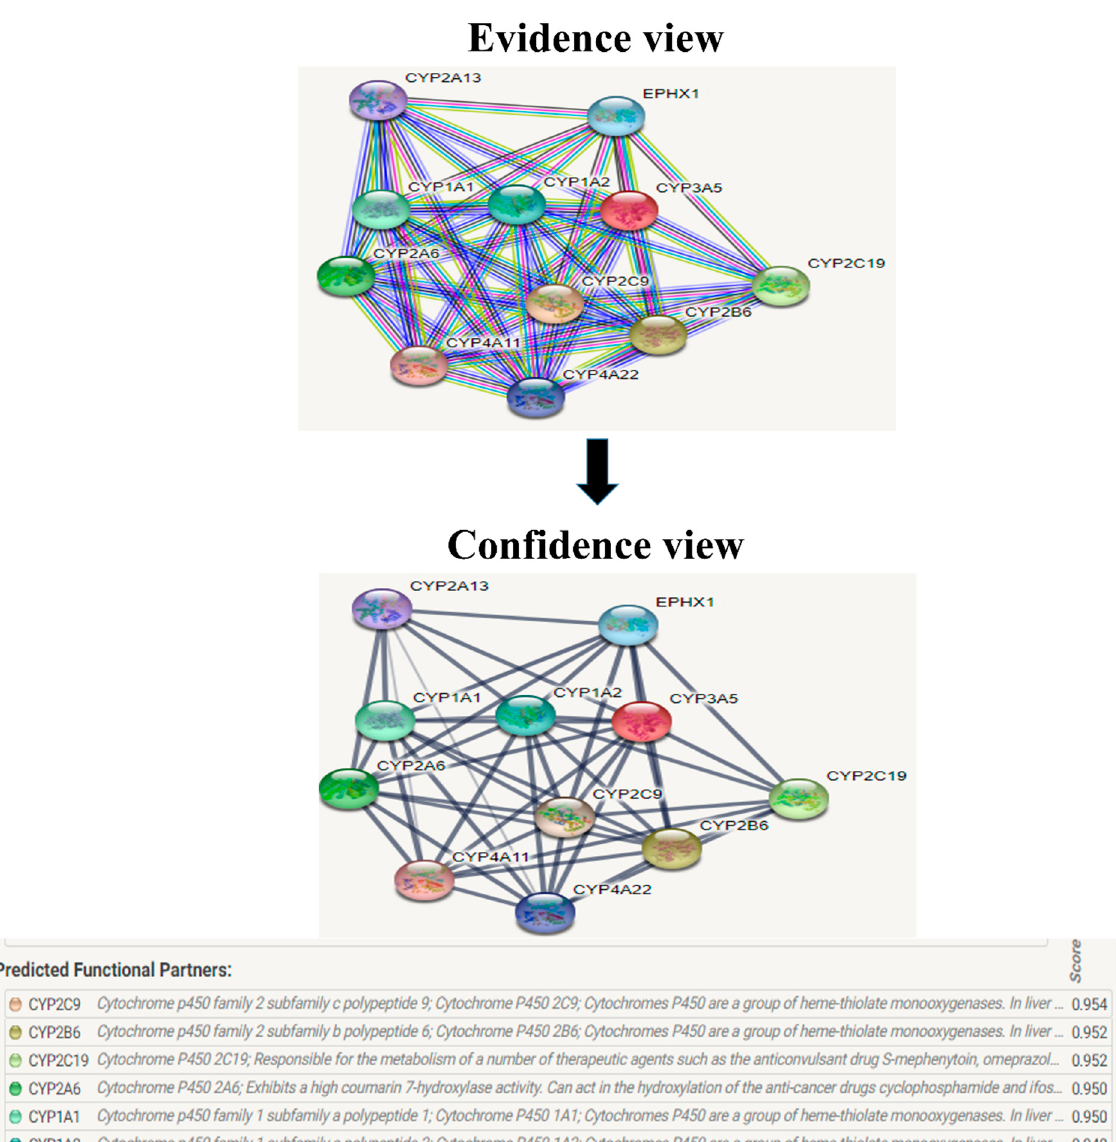
Figure 12. CYP3A5 interacts with a total of 10 different proteins. The evidence view and confidence view are given, while dark blue lines indicating a strong link.